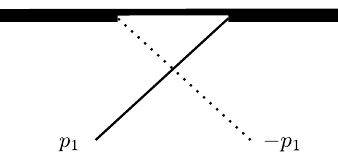
Figure 3 . Coleman-Thun diagram for excited boundary states signaling a pole at the ground state excitation